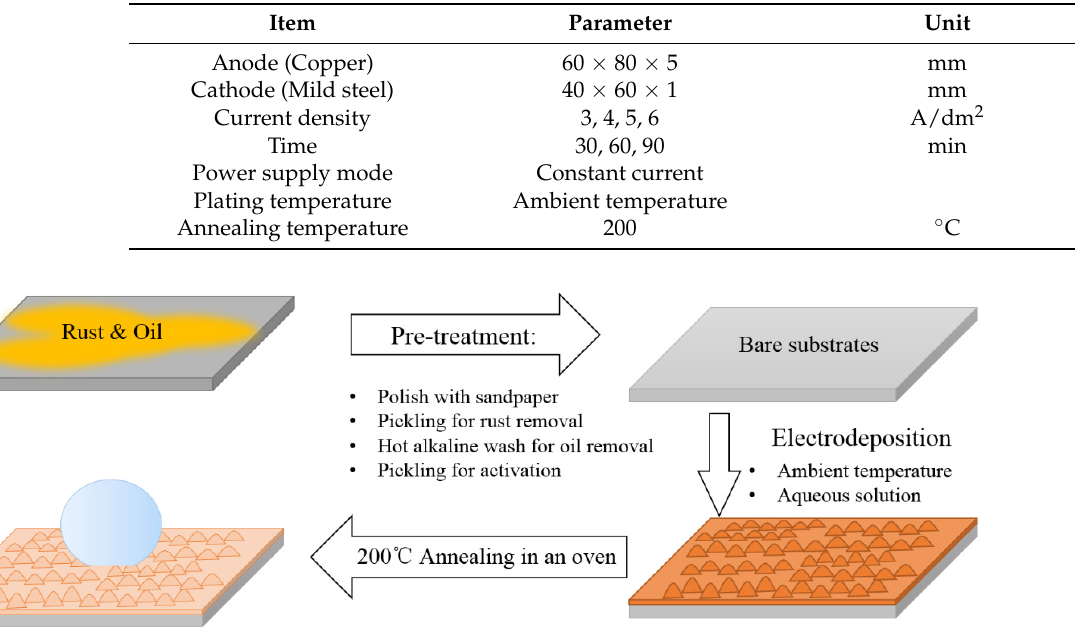
Table 1. Plating conditions and specific processing parameters.